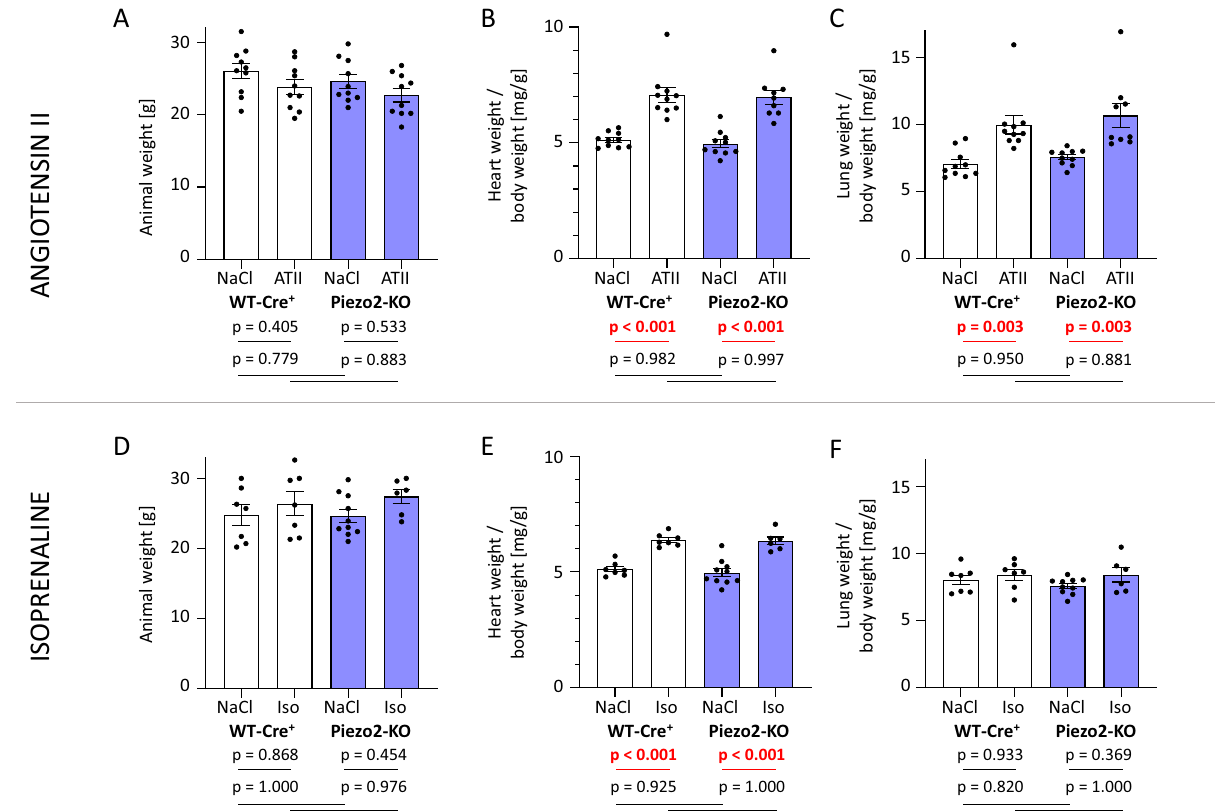
Figure 4. Animal or organ weights of WT-Cre + and Piezo2-KO mice after angiotensin II or isoprenaline treatment. ( A ) Animals were weighed, and ( B ) heart weight/body weight ratios and ( C ) lung weight/body weight ratios were determined after explantation of the organs following three weeks of angiotensin II (ATII) treatment. Accordingly, ( D ) animal weights, ( E ) heart weight/body weight ratios and ( F ) lung weight/body weight ratios were assessed after one week of isoprenaline (Iso) clearly positive. The WT-Cre + controls displayed both a patchy cardiomyocyte pattern (similar to Fig. 2D + F) and positive staining for smooth muscle cells. Neither the heterozygous (Het Piezo2-KO) nor the homozygous (Piezo2-KO) piezo2-KO mice displayed any morphological or behavioral abnormalities under non-stressed conditions. A limited number of animals were also investigated by exploratory echocardiography, but no functional or morphological difference from WT mice could be observed (Fig. S3).